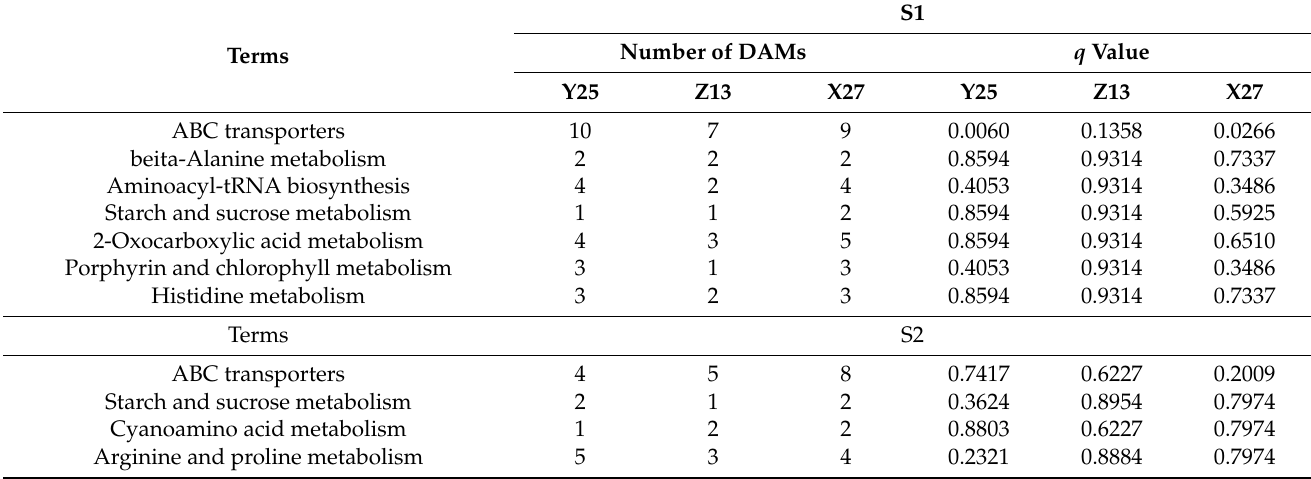
Table 1. Number of DAMs in co-enriched metabolic pathway between S1 and S2 growth periods.